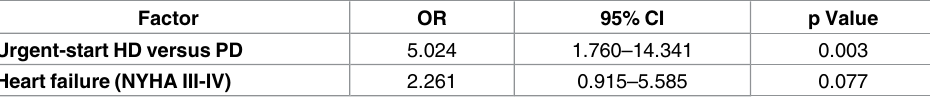
Table 4. Predictors of Short-term Dialysis-related Complications by Logistic Regression